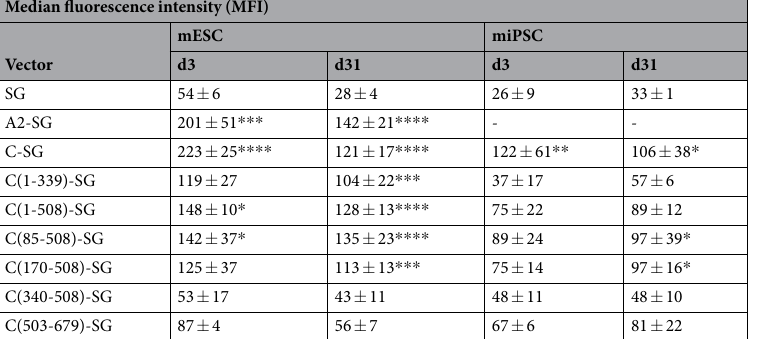
Table 2. Expression intensity of CBX3 subfragments in pluripotent stem cells. eGFP fluorescence mediated by the UCO elements was compared to the SG negative control. Data represent independent experiments n =